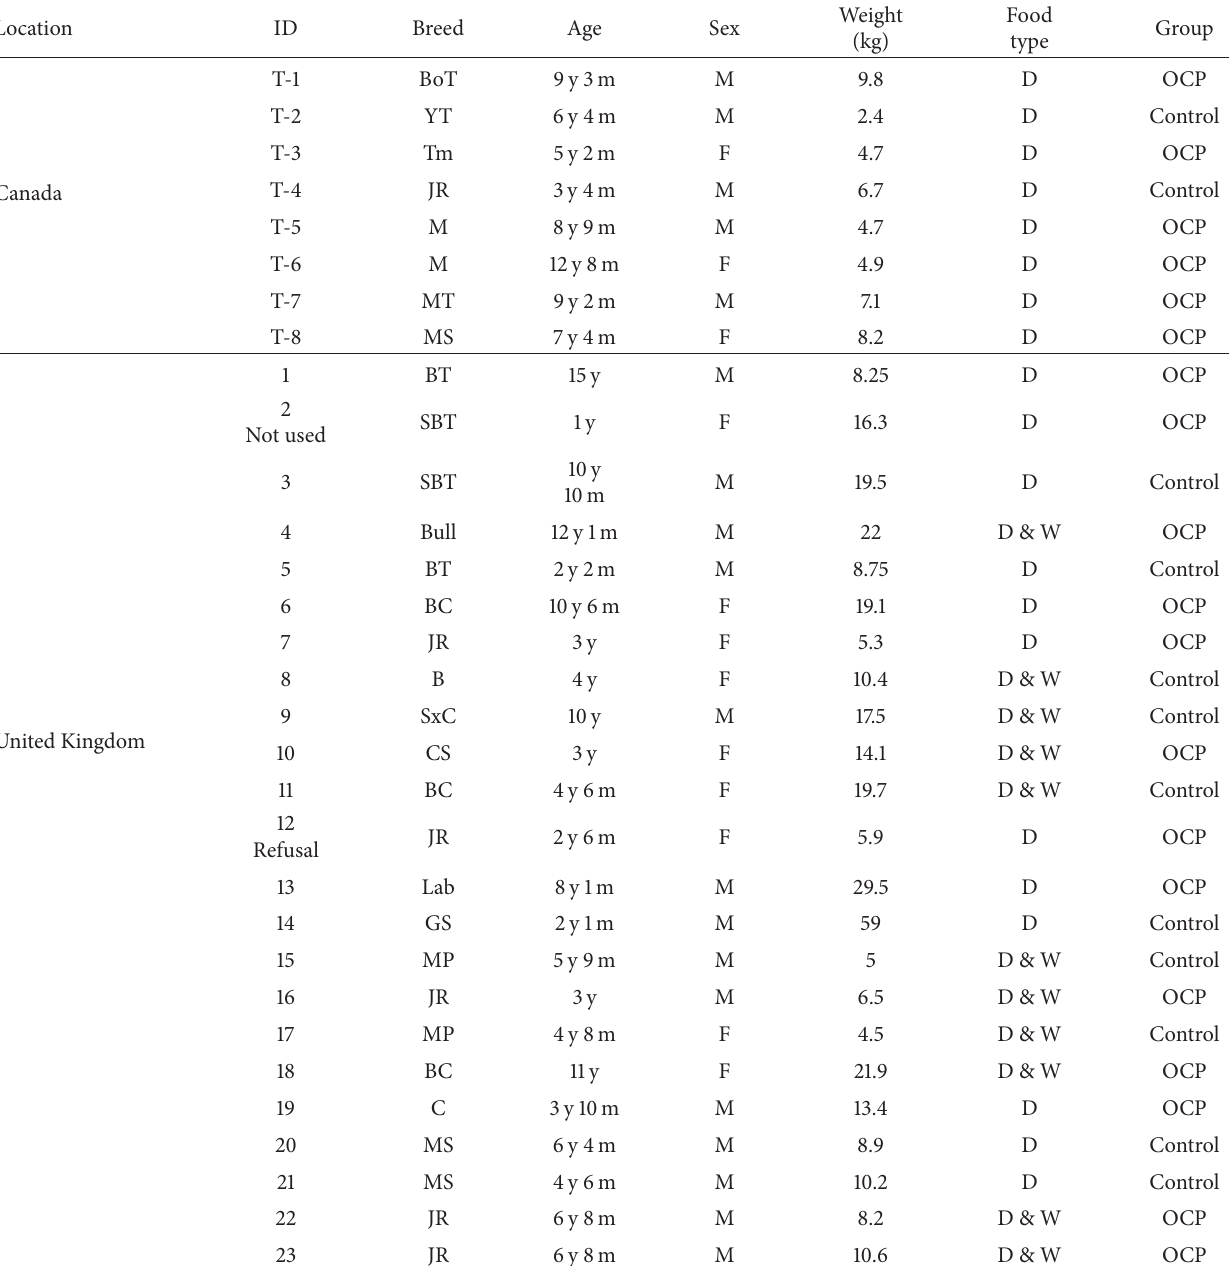
Table 1: Dogs recruited into the